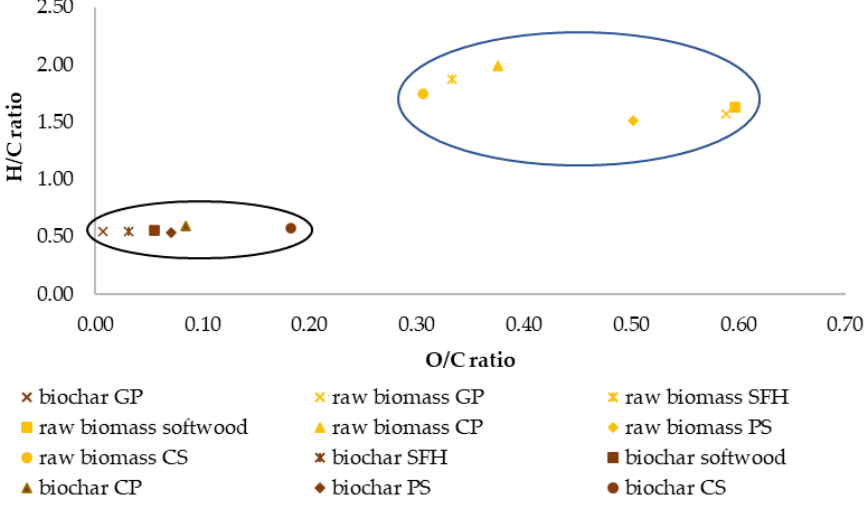
Figure 5. Van Krevelen diagram of the used raw biomass and the obtained biochar.